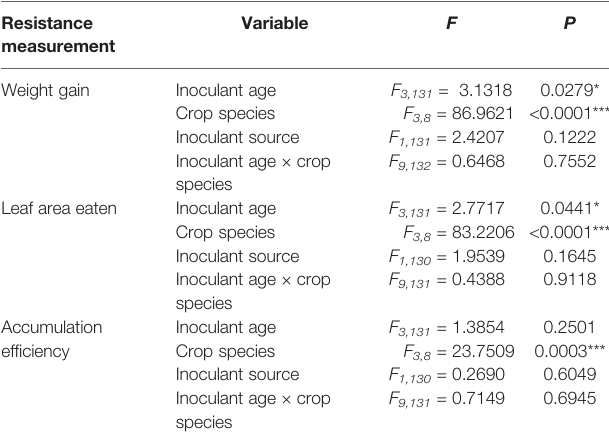
different ages (1, 3, or 16 years post-agriculture), with 2 plots representing each age (inoculant source). Herbivore resistance was measured in no-choice bioassays with c. 6 d old T.ni larvae,in whichweight gain,leafarea eaten,andbiomass accumulationef fi ciency were measured after feeding for 3 (maize, tomato, and cucumber assays) or 4 d (lettuce assays). N = 8-12 replicates per species × inoculant age treatment after omitting insects that died, lost weight, or did not eat. *p < 0.05, ***p <